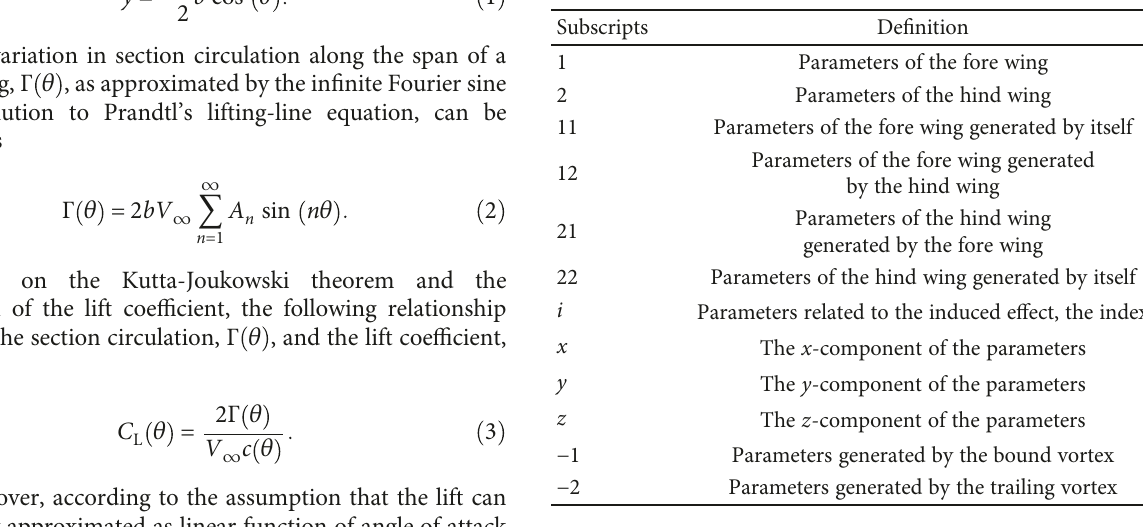
Table 1: De fi nition of the subscripts of the